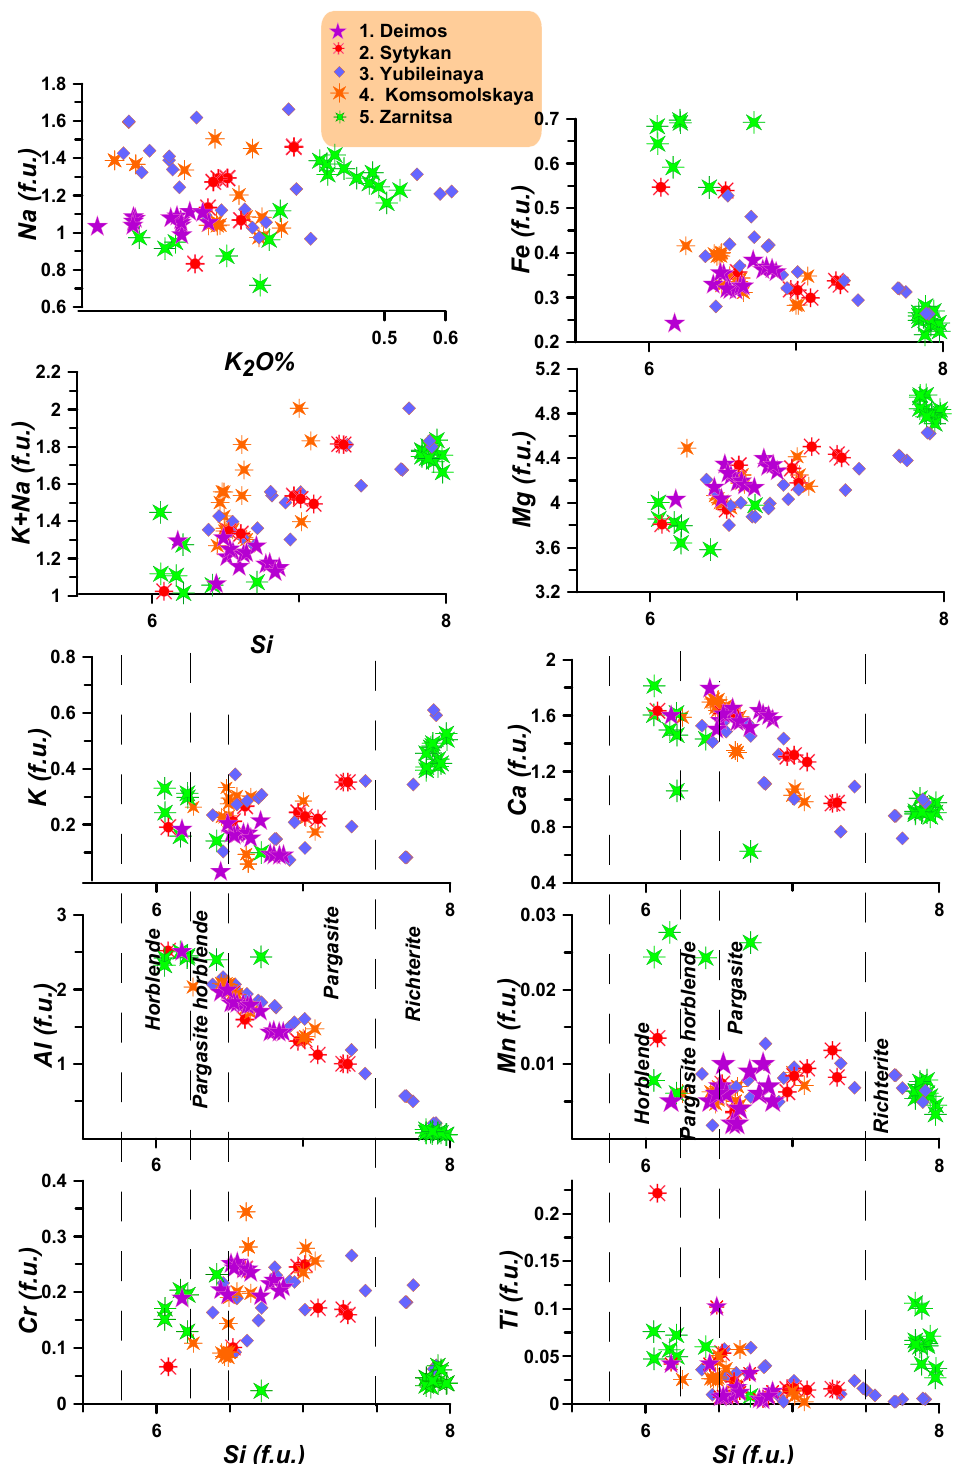
Figure 9. Compositions of amphiboles from Daldyn and Alakit fields and Upper Muna field. Data are partly published [2,3,12].